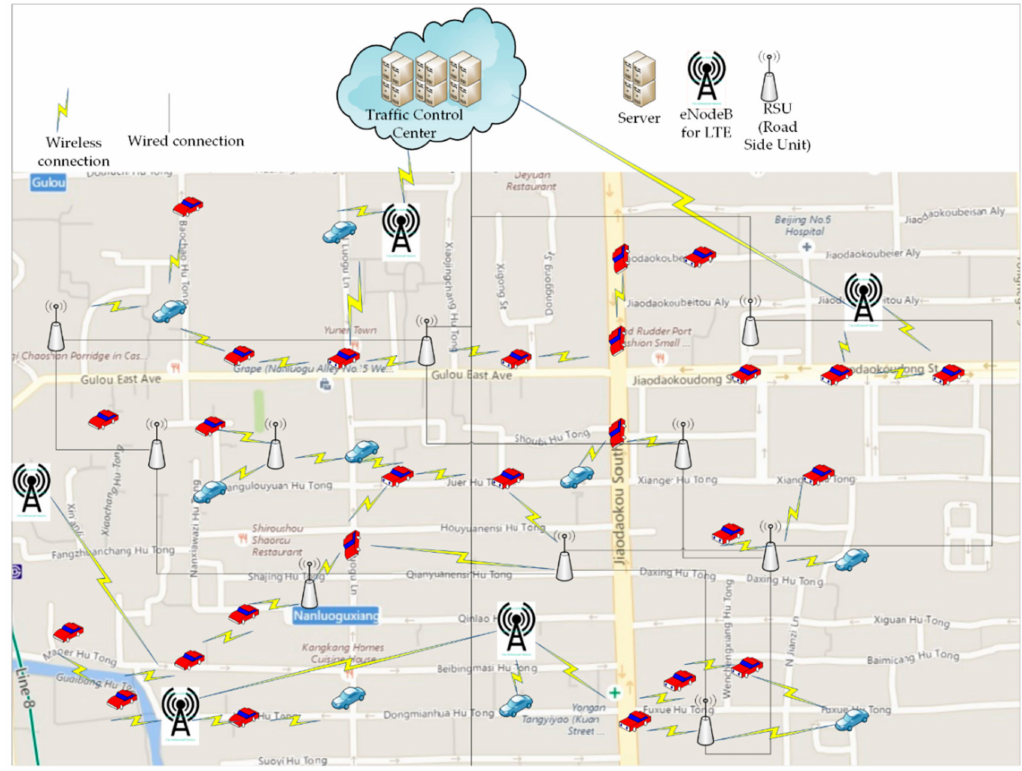
Figure 1. Vehicular navigation